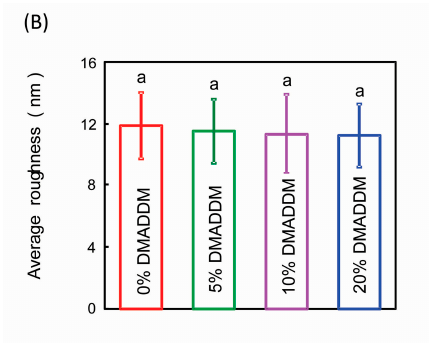
Figure 5. Surface roughness of different mass fraction of DMADDM resins. ( A ) a : The typical AFM image of a surface in the control group. b : The typical AFM image of a surface in the 5% DMADDM group. c : The typical AFM image of a surface in the 10% DMADDM group. d : The typical AFM image of a surface in the 20% DMADDM group; ( B ) The average roughness of acrylic resin. In each plot, similar letter indicates that there was no significant difference between the groups ( p > 0.1).